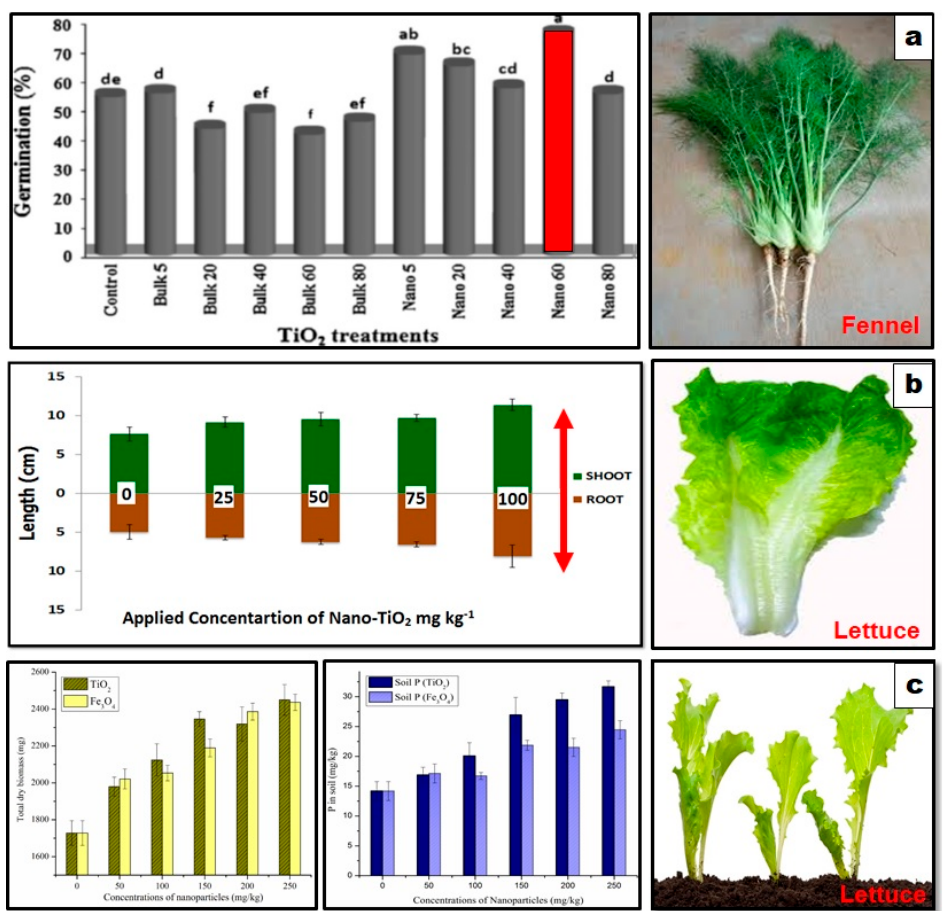
Figure4. E ff ectsofTiO 2 NPsonplantswithrespecttodi ff erentstages, concentrationrange,